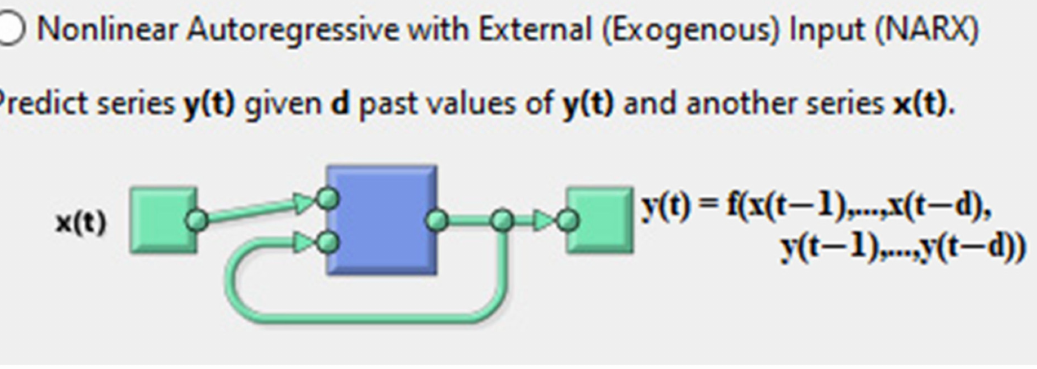
Figure 2. General architecture of a NARX model of neural networks and its